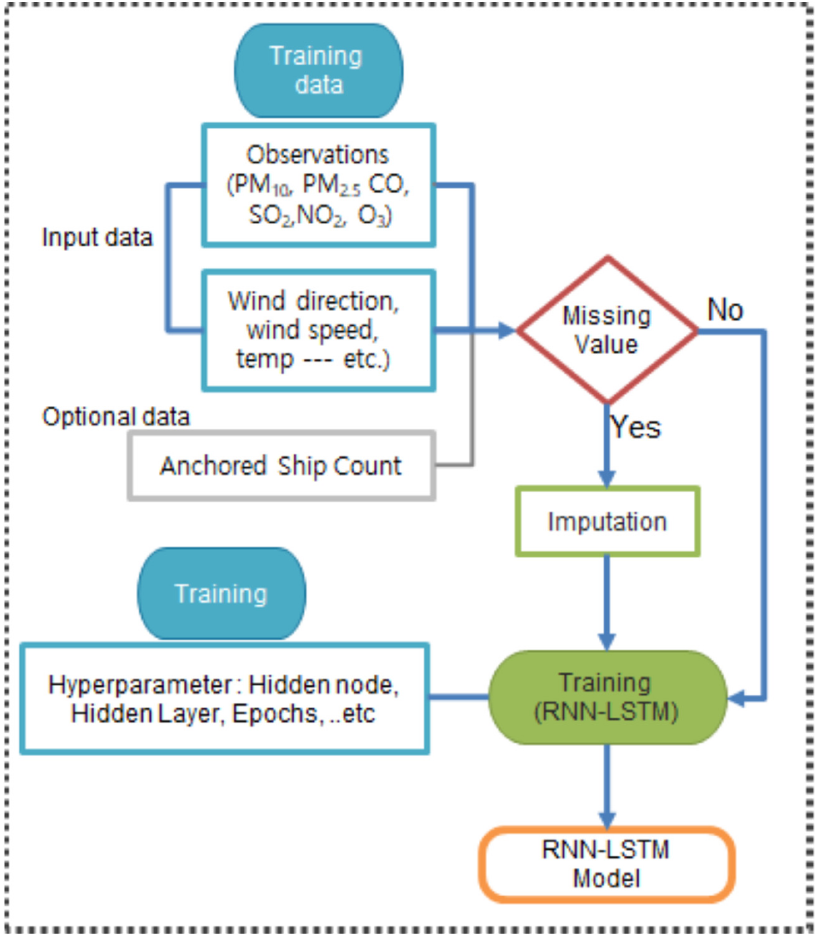
Figure 5. Operating procedure of RNN-LSTM .